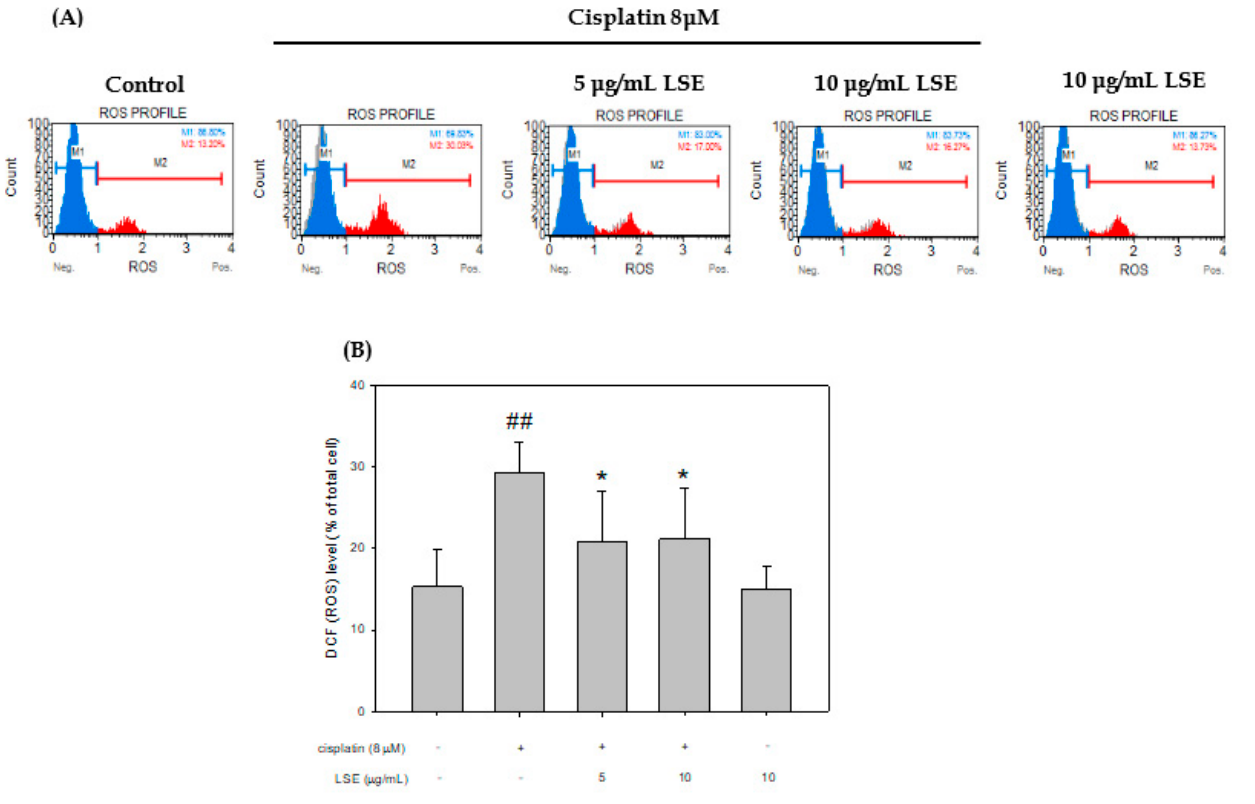
Figure 2. Effect of LSE on cisplatin-induced ROS production in NRK − 52E cells. NRK − 52E cells were treated with or without LSE (5, 10 µ g/mL) for 24 h in the presence or absence of cisplatin (8 µ M). ( A ) The ROS production was assayed with flow cytometry. ( B ) The DCF-positive cells divided by the total number of cells were calculated. Quantification data were presented as mean ± SD of three independent experiments by using Sigma plot 10.0 software. ## p < 0.01 compared with the control group; * p < 0.05 compared with the cisplatin group.